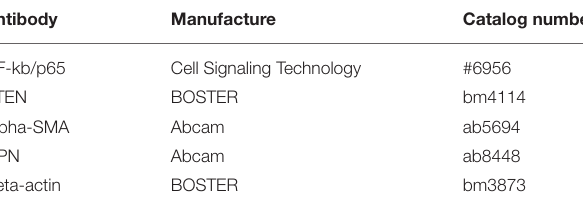
TABLE 1 | Antibodies